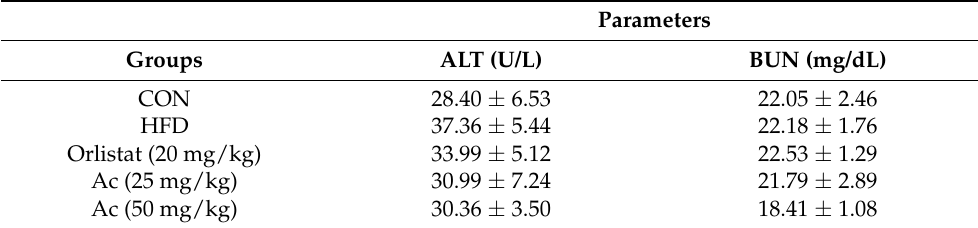
Table 4. The liver and kidney toxicity in the serum of Ac-treated obese